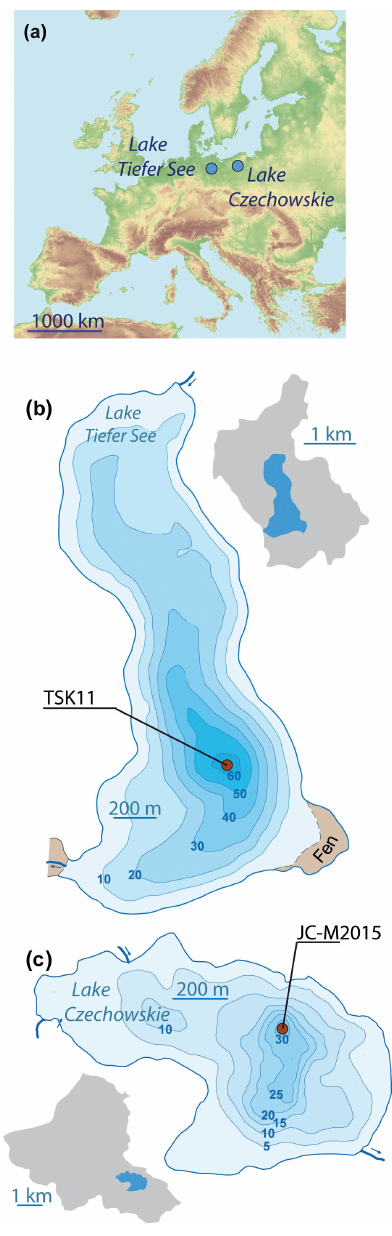
Figure 1. Settings of Tiefer See (TSK) and Lake Czechowskie (JC). (a) Location of TSK and JC in the southern Baltic lowlands. (b) Bathymetric map of TSK with position of sediment core TSK11 and lake-catchment sketch. (c) Bathymetric map of JC with position of sediment core JC-M2015 and lake-catchment